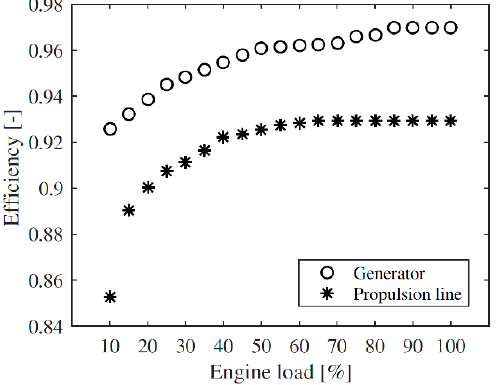
Figure 4. Generator and propulsion line efficiencies as a function of the engine load.